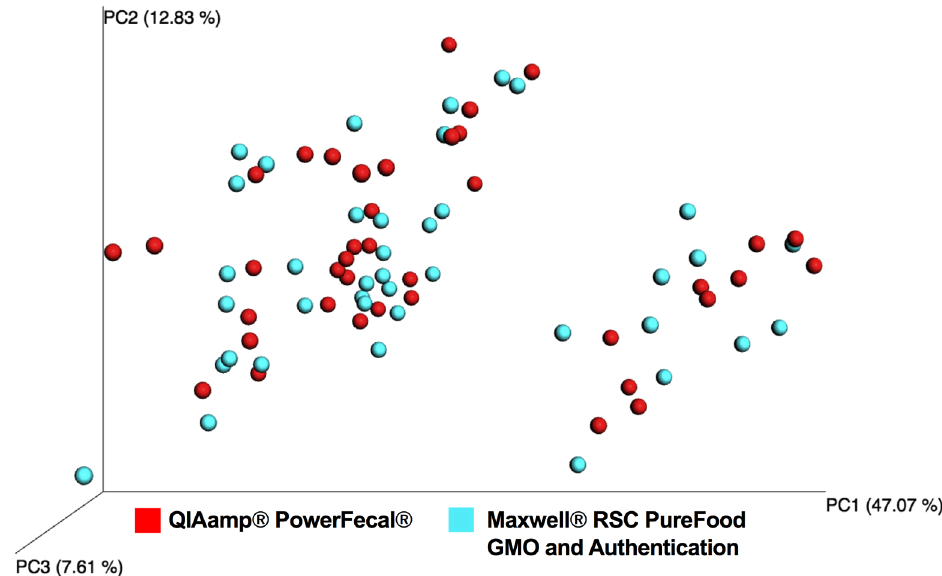
Fig 5. Weighted Unifrac principal coordinate analysis (PCoA) of samples with successful amplification and sequencing. Colors denote DNA extraction method: QIAamp 1 PowerFecal 1 Kit ( red ) and Maxwell 1 RSC PureFood GMO and Authentication Kit ( blue